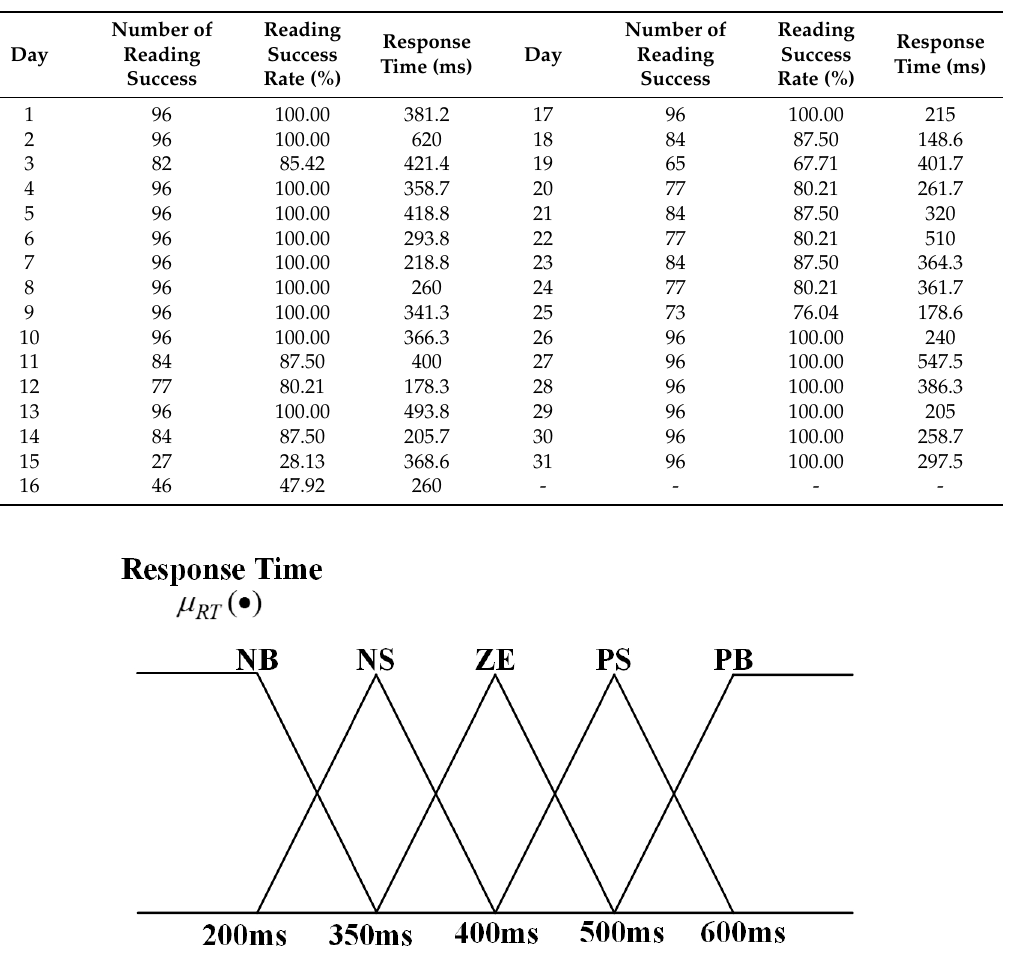
Figure 16. Membership Function of Response Time for Actual Small-Scale PLC-based AMI.